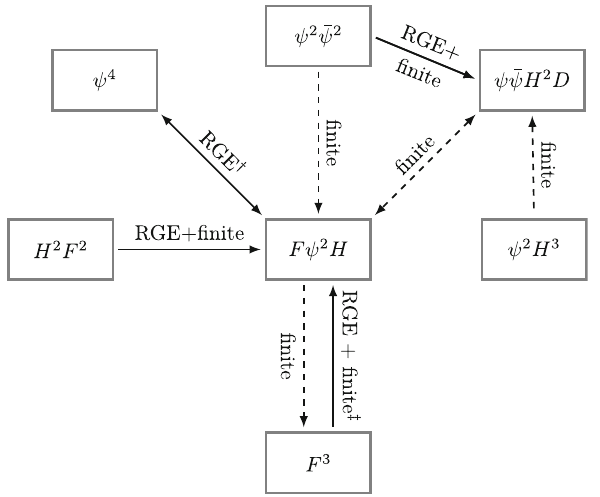
Fig. 2 Contributions to the operators entering the dipoles. Operators connected with solid arrows enter the RGEs, while dashed arrows describe purely finite effects. The † indicates that the operator O (1) is not included in the ψ 4 class here. Interestingly, we find that the oth- ers operators in this class only enter via the RGE, generating no rational terms. The ‡ shows that the operator O (cid:20) W gives only rational terms